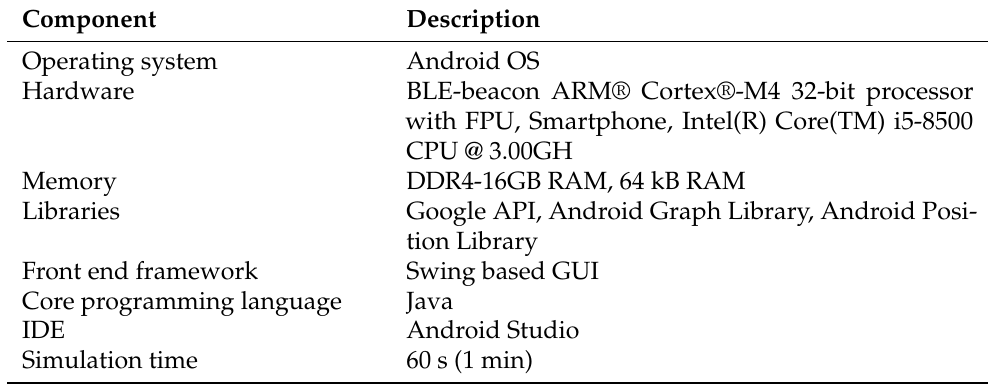
Table 5. Implementation environment.